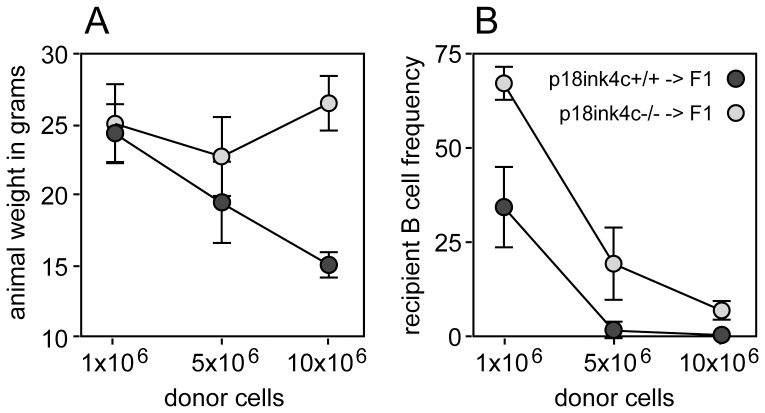
Effect of p18ink4c deficiency on the development of graft-vs.-host disease.C57BL/6 X BALB/c F1 mice aged 4–6 weeks were subjected to irradiation (600 cGy) 6 hours before adoptive transfer of 10×106, 5×106 or 1×106 B6 WT (dark gray symbols, n = 5) or p18ink4c−/− (light gray symbols, n = 5) donor splenocytes. Recipient mice were weighed daily and observed for outward signs of GVHD. On day 13, recipient mice were weighed (A) and sacrificed to determine the frequency of host CD19+ B lymphocytes in the spleen by flow cytometry (B).